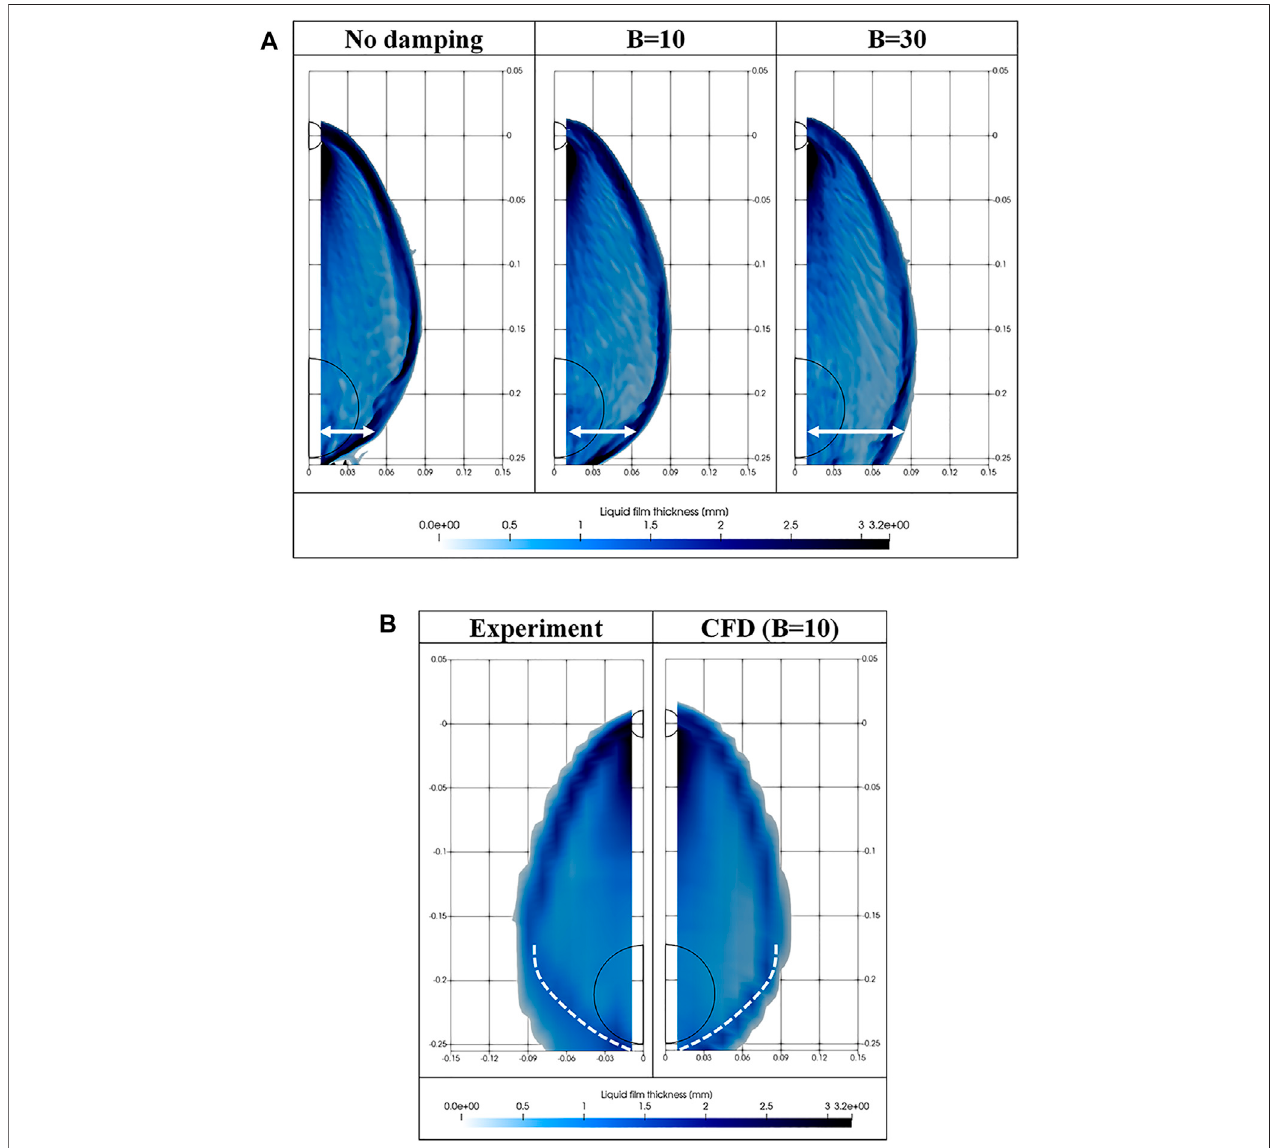
FIGURE 11 | (A) Effect of B on spreading width of liquid fi lm (W063A24). (B) . Comparison of fi lm boundary position for B = 10 (W063A24).